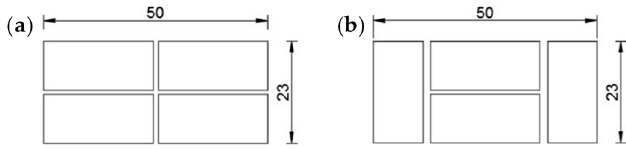
Figure 15. Diagram of laying the bricks for ( a ) the odd rows and ( b ) the even rows (all the measurements in cm) [1].